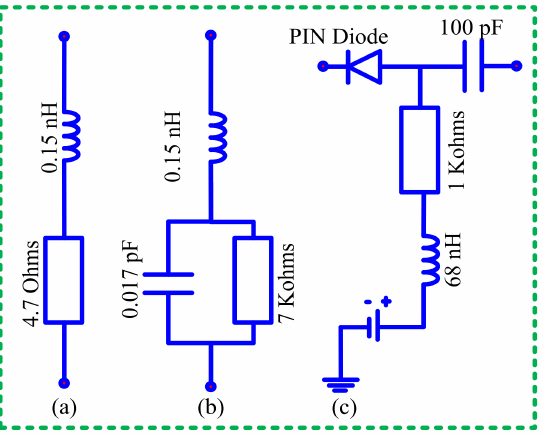
Figure 2. Equivalent model of diode. ( a ) On-state. ( b ) Off-state. ( c ) Biasing